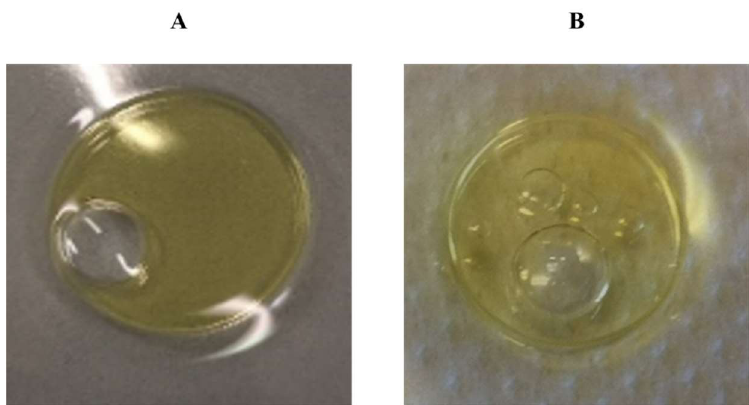
Figure 4. Oil spreading assay to evaluate the surface activity of the unpurified biosurfactant com- pound ( A ) and the purified biosurfactant ( B ) isolated from R . opacus R7 during growth on M9 mineral medium supplemented with naphthalene at 48 h.